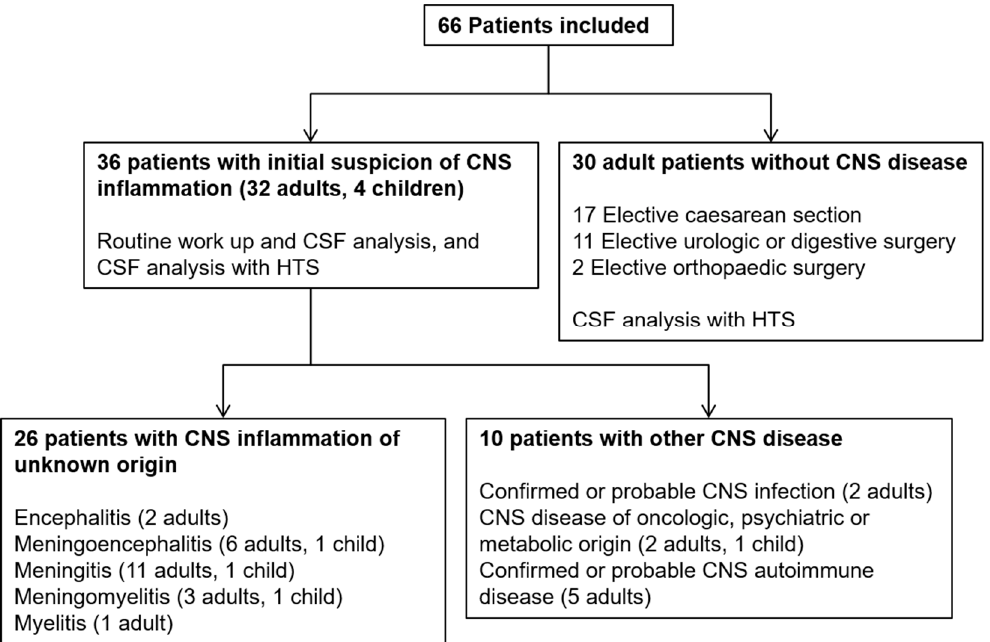
Figure 1. Study flowchart showing patient groups included in the study. Table 2. Demographic characteristics of patients with central nervous system (CNS) disease.